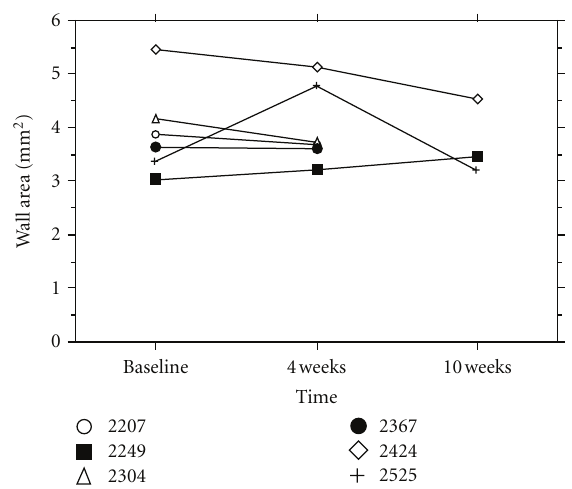
Figure 8: MRI-snakes-measured arterial wall area in lesion at various points in time for each individual animal, 6 slices from each